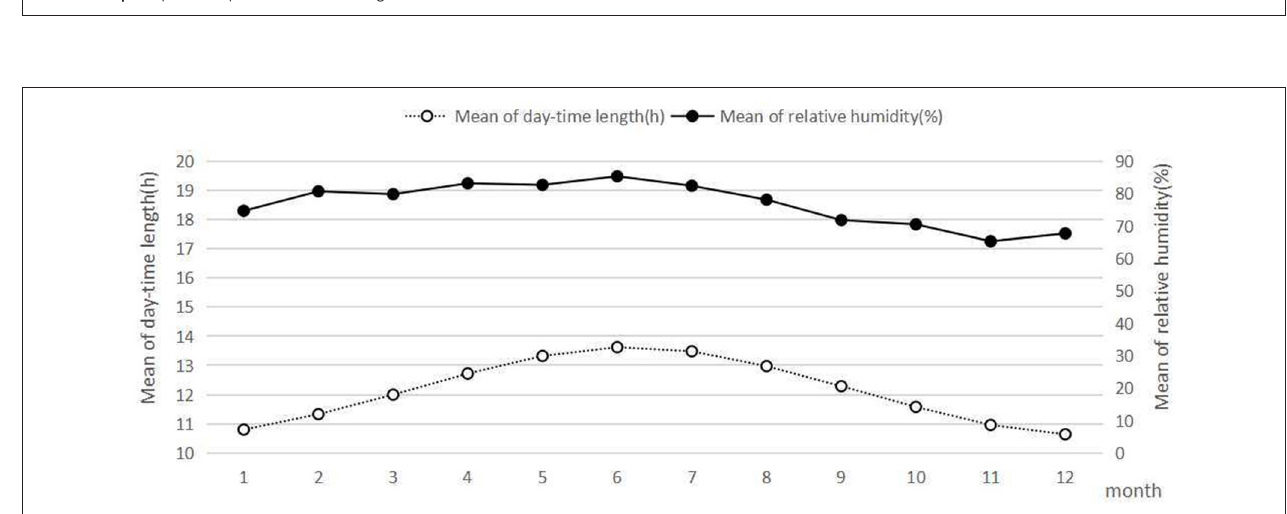
FIGURE 2 | Climatic parameters of Zhangzhou in 2019.